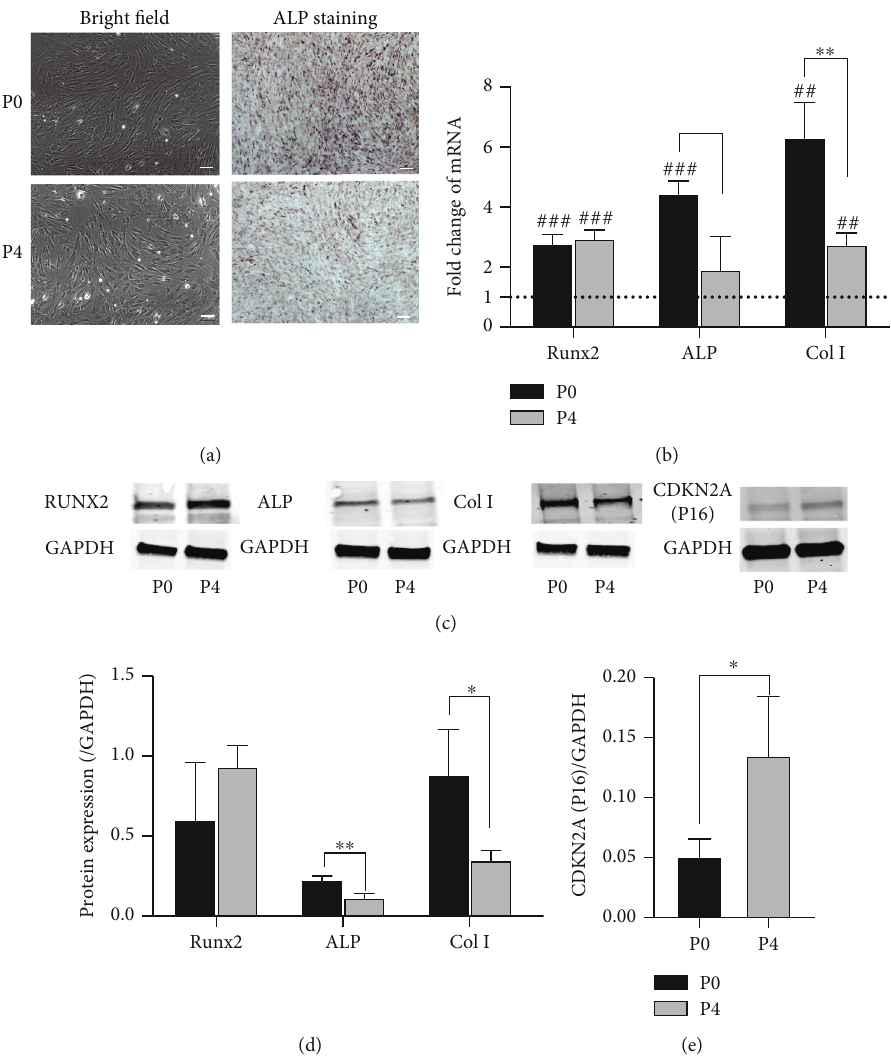
Figure 2: Osteogenic di ff erentiation of P0 and P4 MSCs. Control or senescent cells were cultured with osteogenic di ff erentiation medium for one week and subjected to ALP staining or detection of the gene and protein expression. (a) Representative bright- fi eld images showing the changes in MSCs during di ff erentiation induction and ALP staining, which was stronger in P0 MSCs than in P4 MSCs. Scale bars = 100 μ m . (b) The expression of osteogenic genes (RUNX2, ALP, and Col I) was measured by qPCR with GAPDH as the reference gene. Student ’ s t -test. ∗ p < 0 : 05 versus the corresponding P0 MSCs cultured under the same di ff erentiation conditions; # p < 0 : 05 versus MSCs cultured in basic medium without induction of osteogenic di ff erentiation. (c) The protein blots for RUNX2, ALP, Col I, and CDKN2A (p16) as well as (d) the quanti fi cation of the expression of these proteins relative to that of GAPDH showed that aged P4 MSCs exhibited decreased potency and increased expression of the senescence marker CDKN2A. All these results showed that the inhibition of osteogenic di ff erentiation by expansion was associated with senescence. ∗ p < 0 : 05 versus the corresponding P0